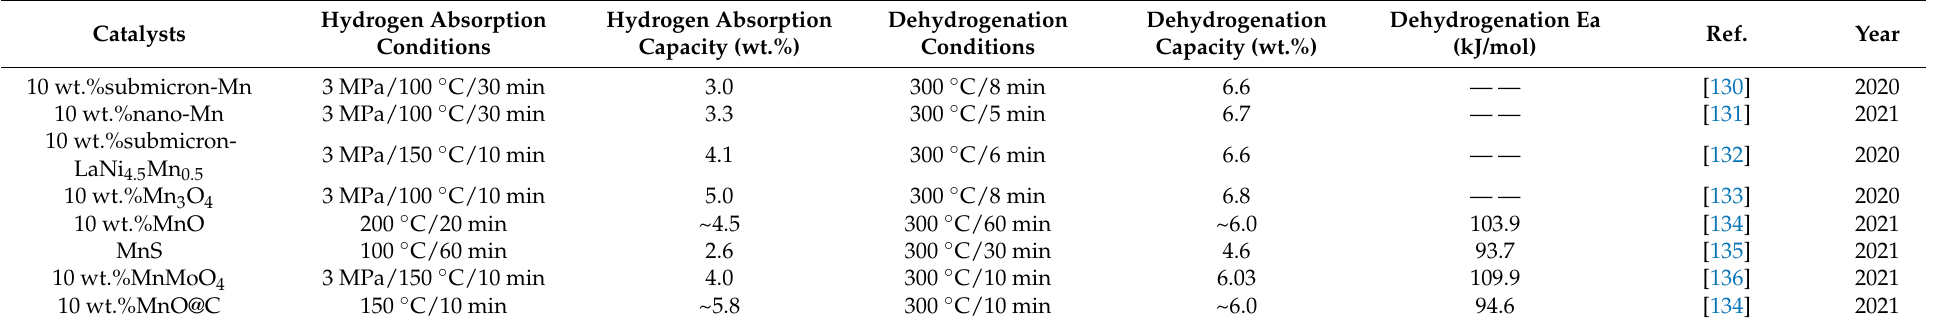
Table 7. Hydrogen storage performance of Mg/MgH 2 system doped with manganese-based